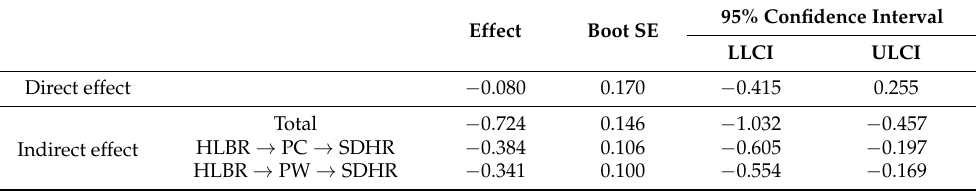
Table 7. Mediating-effect test (China).